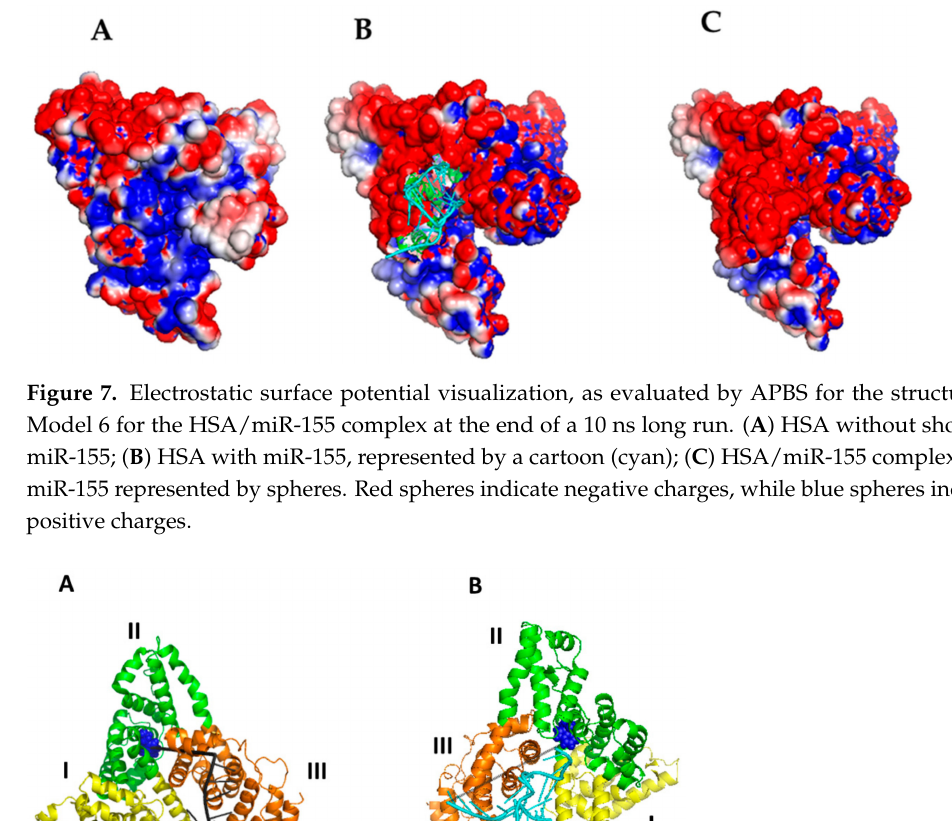
Figure 6. Electrostatic surface potential visualization, as evaluated by APBS for the structure of Model 5 for the HSA/miR-155 complex at the end of a 10 ns long run. ( A ) HSA without showing miR-155; ( B ) HSA with miR-155, represented by a cartoon (grey); ( C ) HSA/miR-155 complex with miR-155, represented by spheres. Red spheres indicate negative charges, while blue spheres represent positive charges.